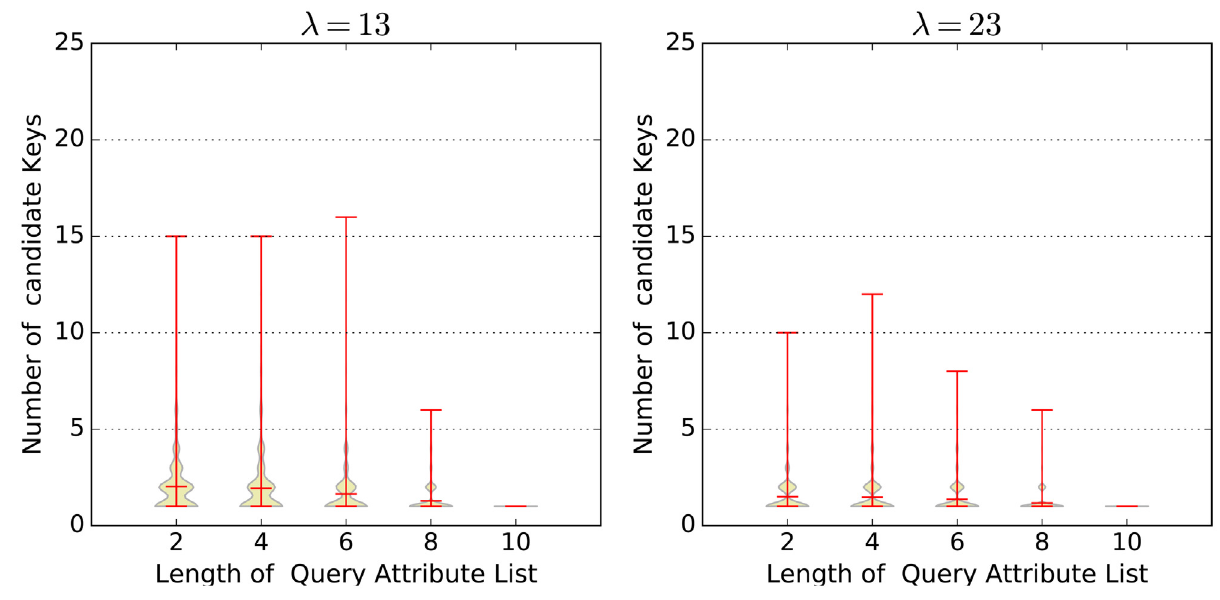
Fig 6. The number of candidate